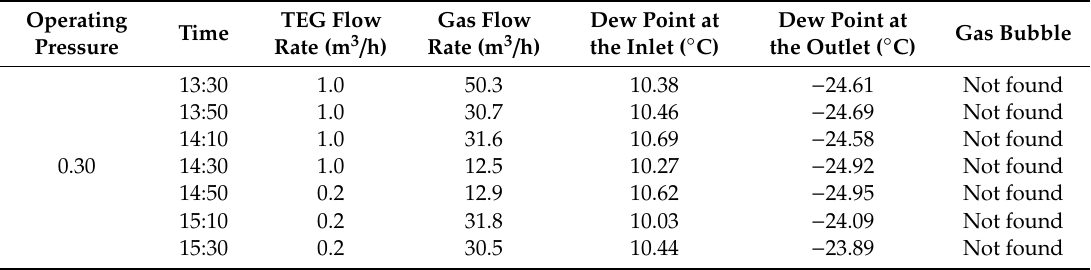
Table 9. Experimental results under sudden change of gas flow